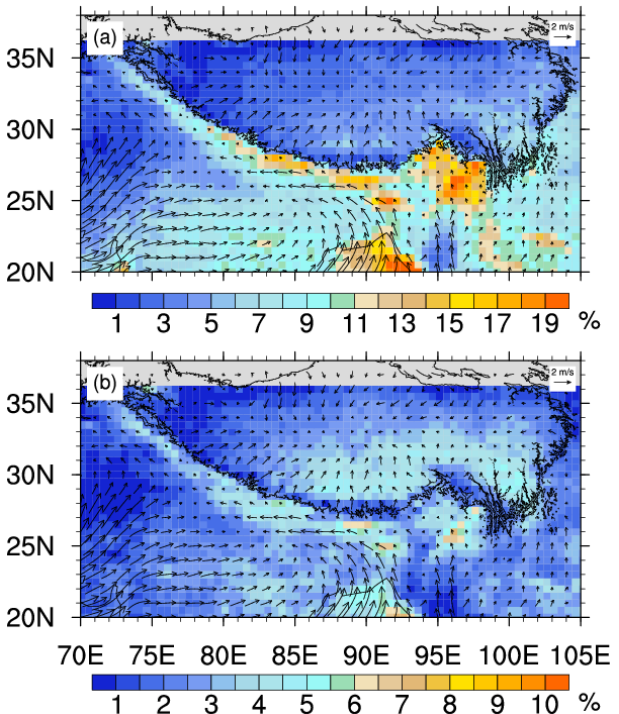
Figure 2. The distribution of ( a ) precipitation frequency and ( b ) DCP frequency in summer over the QTP and its southern regions based on observations of TRMM PR from 1998 to 2012. The surface winds were drawn in each panel calculated by using ERA5 monthly reanalysis data.